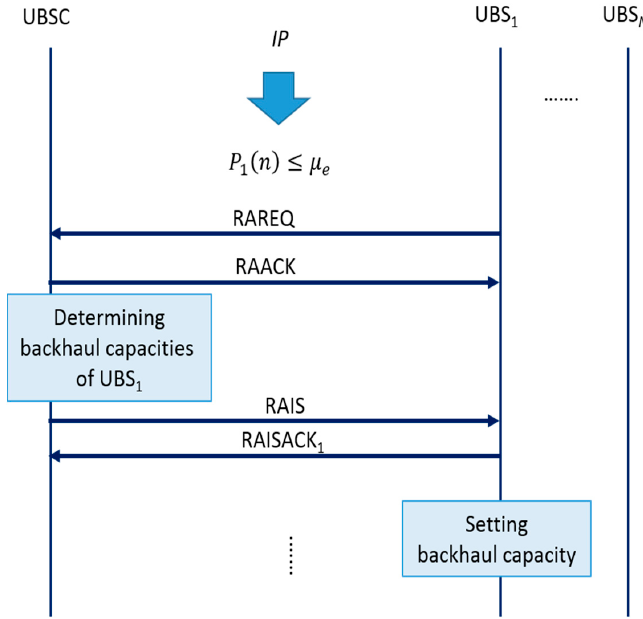
Figure 5. Queue-overflow and sufficient reserved capacity of a UBSC case of the normal operation phase.